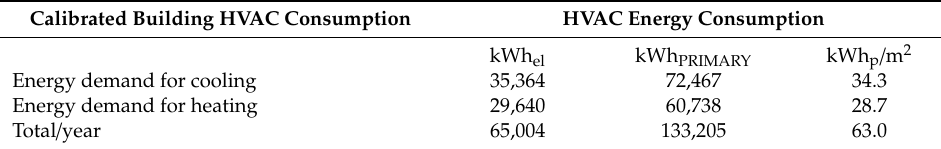
Table 1. HVAC energy consumption of the calibrated building